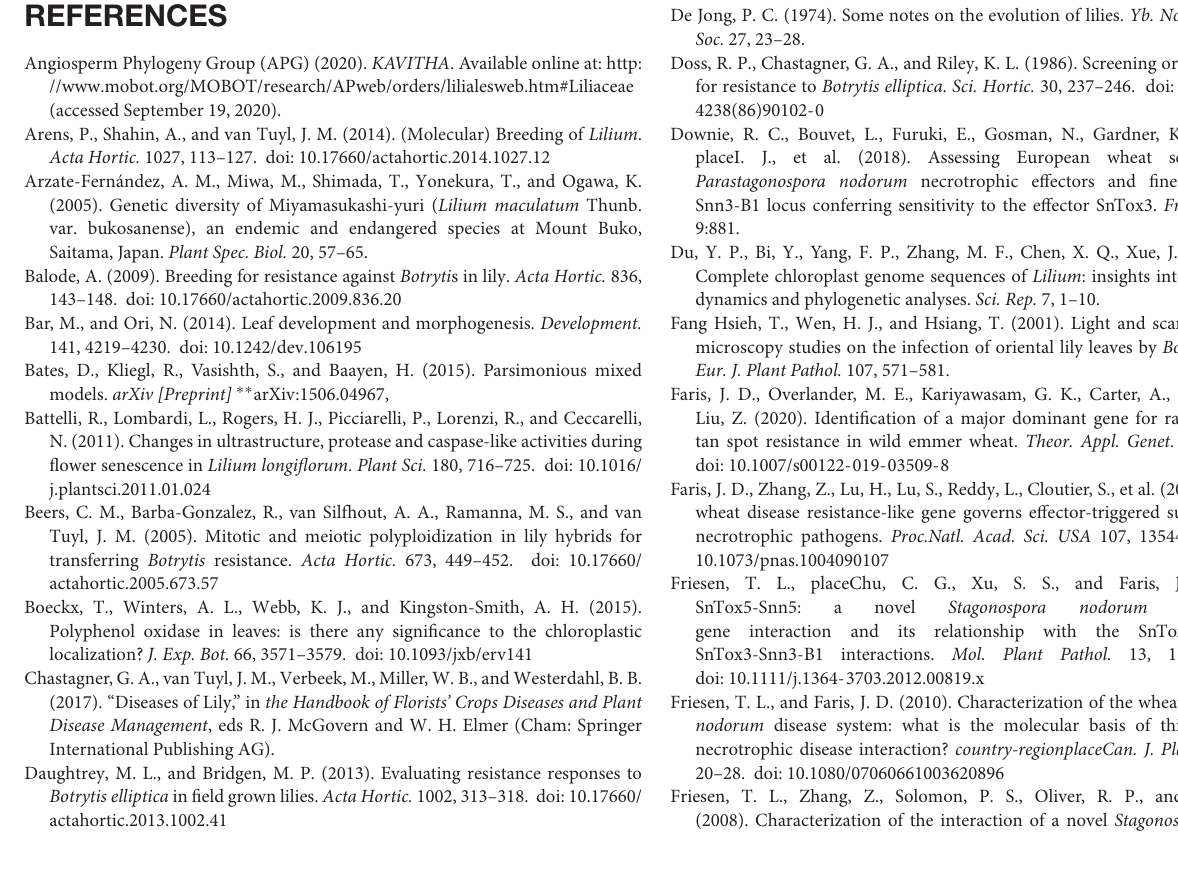
Supplementary Figure 3 | Lesion diameters at 4 dpi upon inoculation of 12 different B. elliptica isolates on leaves of 18 different lily genotypes in early spring 2019 and 2020 (A) and in late spring 2019 and 2020 (B) . Each box represents all compiled lesion diameters measured in mm for a given lily hybrid group in the two seasonal repetitions of the disease assays. Supplementary Figure 4 | Dot plot showing differences in EMMs of lesion diameters on lily leaves in late spring for a given B. elliptica isolate, calculated using lily hybrid group as predicted factor. Red dotted line indicates the average p -value cut off for estimated differences which are significantly different from 0 ( p > 0.05). P -values were adjusted using Tukey’s comparison for a family of 84 estimates. Supplementary Figure 5 | Lesion diameters at 3 dpi upon inoculation of B. elliptica isolates Be9401, Be9732, and Be0006 and B. cinerea isolate B05.10 on detached leaves of 12 cut lily genotypes. Lesion diameters measured in mm of each single fungus are plotted separately in the four panels. Each of the colored boxes represents all lesion diameters measured for a given lily hybrid group. Supplementary Figure 6 | Necrotic lesions developing at 3 dpi upon inoculation of Be9401, Be9732 and Bcin on leaves of cut lily genotypes A 3, LA 2, L 1, LO 1, OT 3, and O 3 from which also the flowers were tested. For each cultivar, 12 inoculations were performed on two or three leaves detached from fresh harvested lilies. Supplementary Figure 7 | Dot plot showing differences in EMMs of lesion diameters on lily flowers for a given Botrytis isolate calculated using lily hybrid group as predicted factor. Red dotted line indicates the average p -value cut off for estimated differences which are significantly different from 0 ( p > 0.05). P -values were adjusted using Tukey’s comparison for a family of 24 estimated. Supplementary Figure 8 | Dot plot showing differences in EMMs of lesion diameters measured on leaves of lilies for a given Botrytis isolate calculated using lily hybrid group as predicted factor. Red dotted line indicates the average p -value